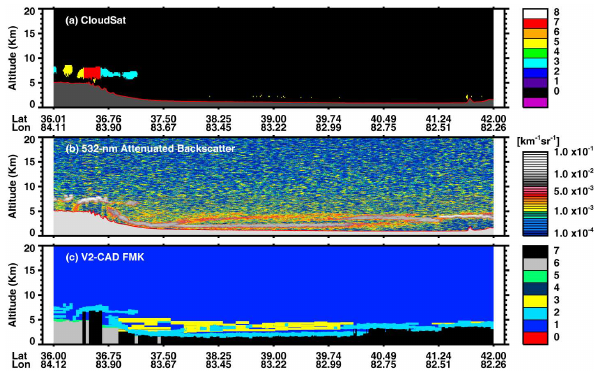
Fig. 2. (a) CloudSat level 2 cloud scenario classification prod- uct, and color bar indicates feature type (0=invalid, 1=high cloud, 2=As, 3=Ac, 4=St, 5=Sc, 6=Cu, 7=Ns, and 8=Deep convec- tive clouds). (b) CALIPSO altitude-orbit cross section measure- ments of 532-nm total attenuated backscatter intensity (km − 1 sr − 1 ). (c) V2-CAD method vertical Feature Mask (FMK) measurements, Color bar indicates feature type (feature type: 0=invalid, 1=clear air, 2=cloud, 3=aerosol, 4=stratospheric feature, 5=surface, 6=subsurface, 7=no signal), in the CALIOP current version 2.01 data for 22 April 2007.